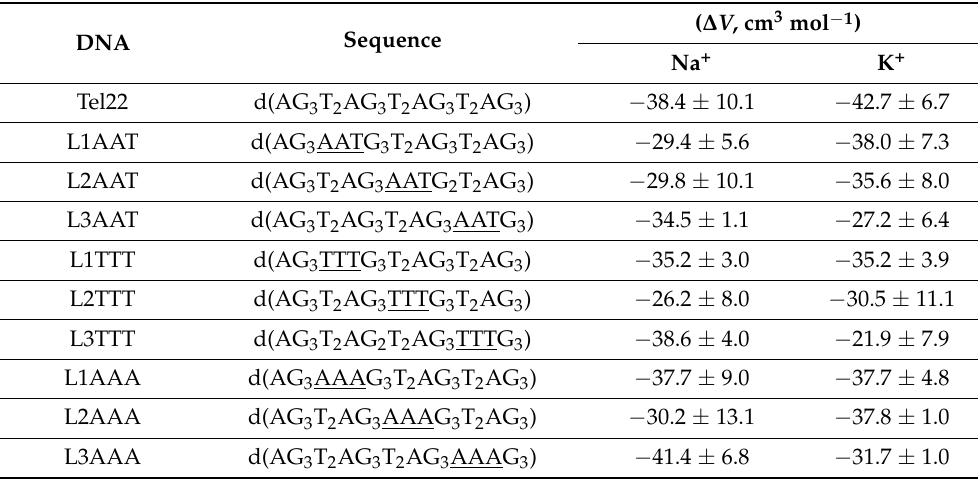
a from ref. [94]; b from ref. [101]; c the solutions contained 30 mM Tris-HCl at pH 7.0 and 100 mM KCl; d the solutions contained 30 mM Tris-HCl at pH 7.0, 100 mM KCl, and 40 wt% PEG200; e the unfolding transition at atmospheric pressure. Table 4. Volume changes associated with the unfolding of the original and modified human telomeric G-quadruplexes in the presence of Na + or K + at 57 ◦ C, ∆ V 57 (cm 3 mol − 1 ), presented by Li et al. [97]. The changes to the original Tel22 sequence are underlined. Values were obtained by analyzing the effect of hydrostatic pressure on the equilibrium between the folded and unfolded states of the respective G-quadruplexes assuming a two-state monomolecular reaction. The values were extrapolated to a common temperature of 57 ◦ C which corresponds to the average T M of the G- quadruplexes studied. All samples contained 10 mM Tris at pH 7.4, 0.1 mM EDTA, and either 100 mM NaCl or 100 mM